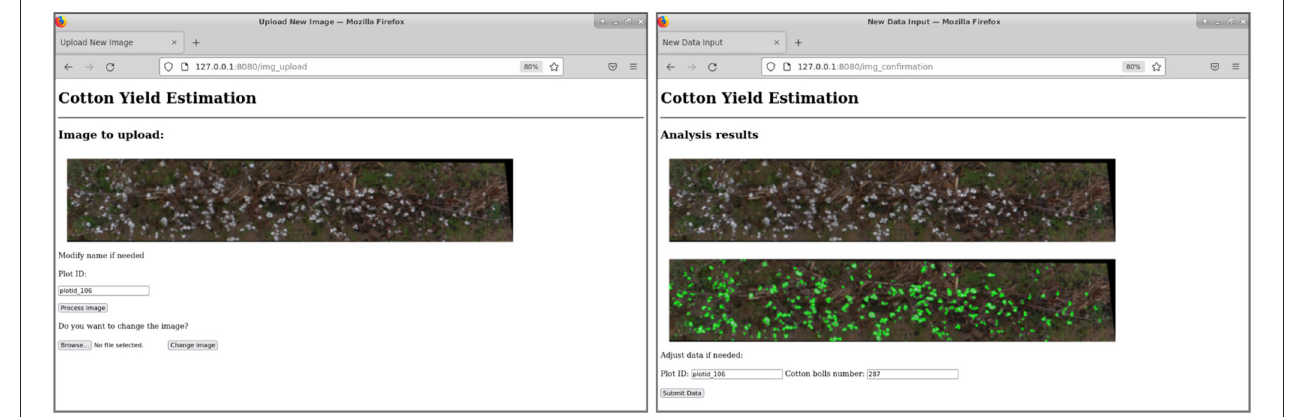
FIGURE 11 | Web API for automatic image analysis.